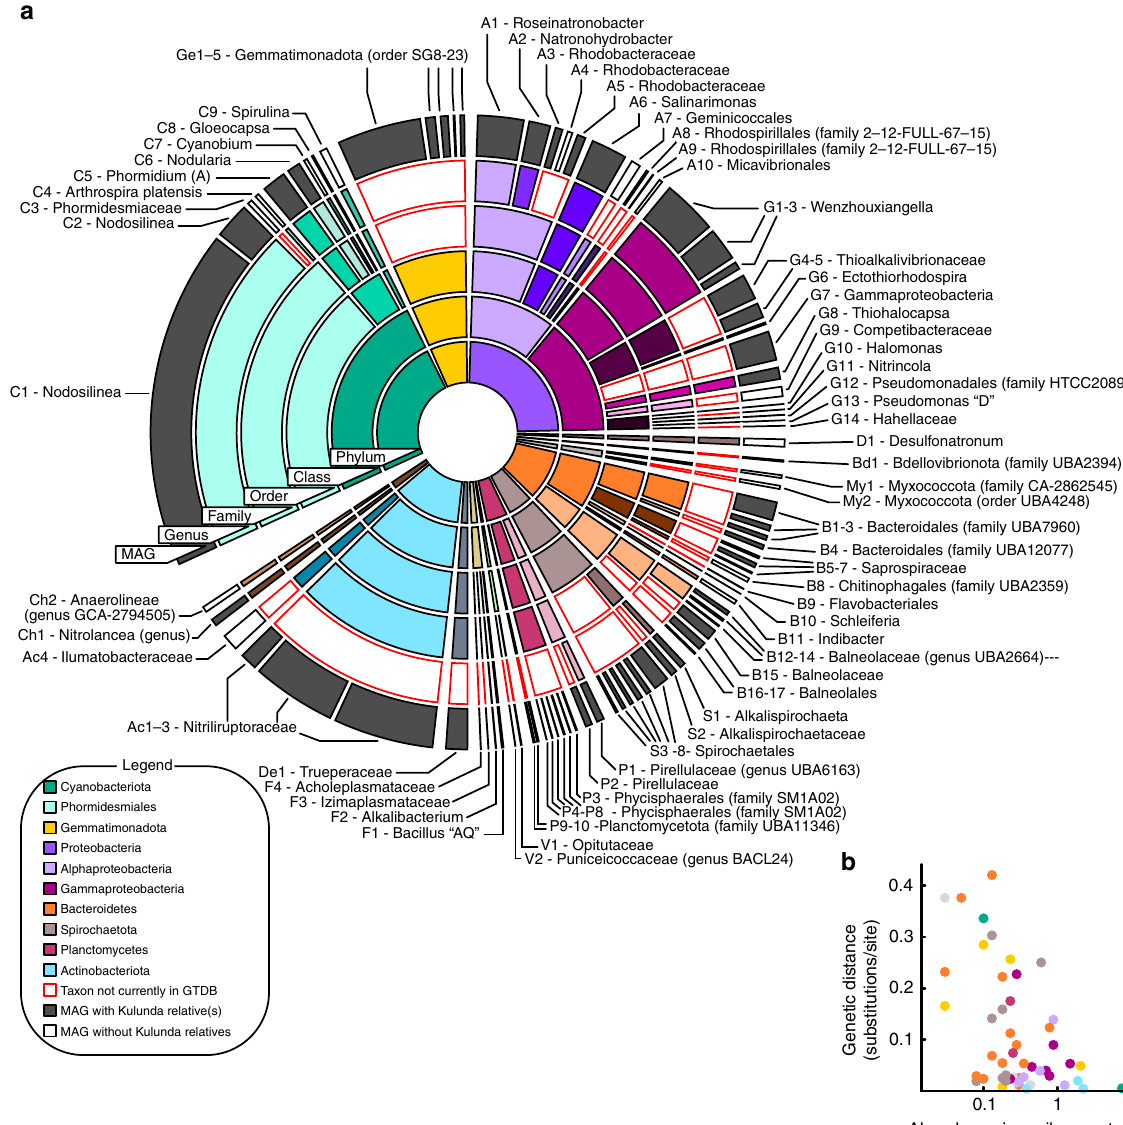
Fig. 2 Relative abundance and diversity of soda lake metagenome-assembled-genomes. a Sunburst diagram showing relative abundances and GTDB taxonomic classi fi cations of metagenome-assembled-genomes (MAGs) obtained from Cariboo lakes. Core-microbiome MAGs with closest relatives among Central Asian (Kulunda) soda lake MAGs are shown in grey. Red outlines indicate new clades that were not yet represented in GTDB. For example, MAG C1, the most abundant MAG, is af fi liated with the genus Nodosilinea , which was represented in GTDB, with a Kulunda MAG more similar than any genome present in GTDB. b Scatter plot showing for each core microbiota the genetic distance between Cariboo and Kulunda representatives as a function of the abundance in Cariboo mat samples. This relationship is statistically signi fi cant (Pearson ’ s correlation r: − 0.49, n = 48, p < 0.05), but no such relationship was detected for the abundance of Kulunda MAGs. See also Supplementary Data